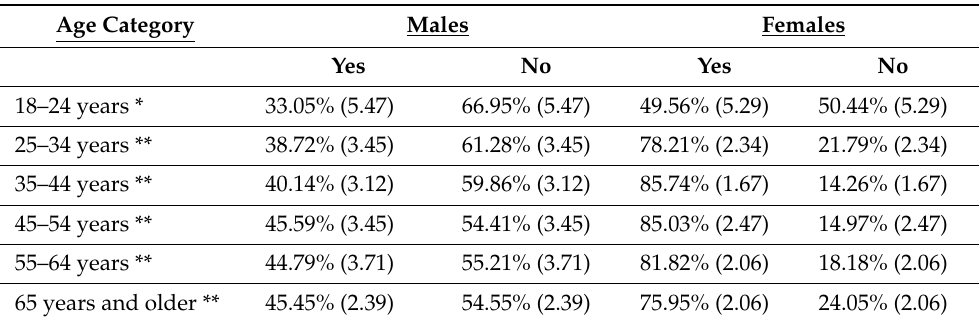
Table 3. Participants’ replies to the question “Are you the person who does most of the shopping for food in family?” stratified by age